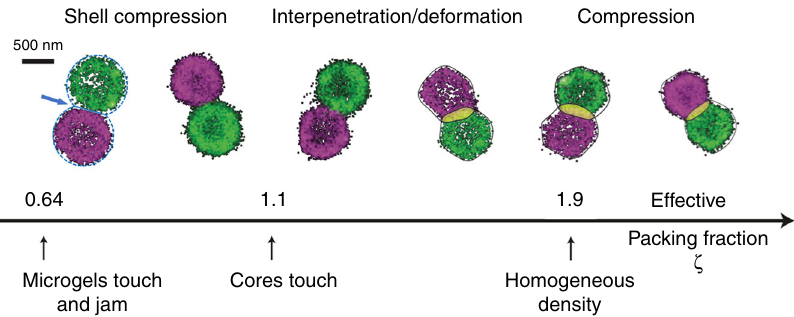
Fig. 2 Two-color dSTORM superresolution microscopy of microgel pairs. Examples for dye-labeled tracer particles seeded in densely packed microgel suspensions are shown ( T = 22 °C) 37 . Particles are labeled with the fl uorophores Alexa Fluor ® 647 or CF680R. The effective packing fraction ζ increases from left to right ( ζ = 0.86, 1.01, 1.26, 1.50, 1.89, 2.13). Left: The dashed circles with radius R tot = 470 nm visualize the total microgel size including the barely visible low-density corona. The arrow points to the contact area where the brush-like corona is partially compressed. The straight line indicates the cross-section of the contact area. Right: The solid lines show the contour of the microgels for higher packing densities where the corona has already been fully compressed onto the core and microgels interpenetrate 37 . The overlap area Δ F is highlighted in yellow